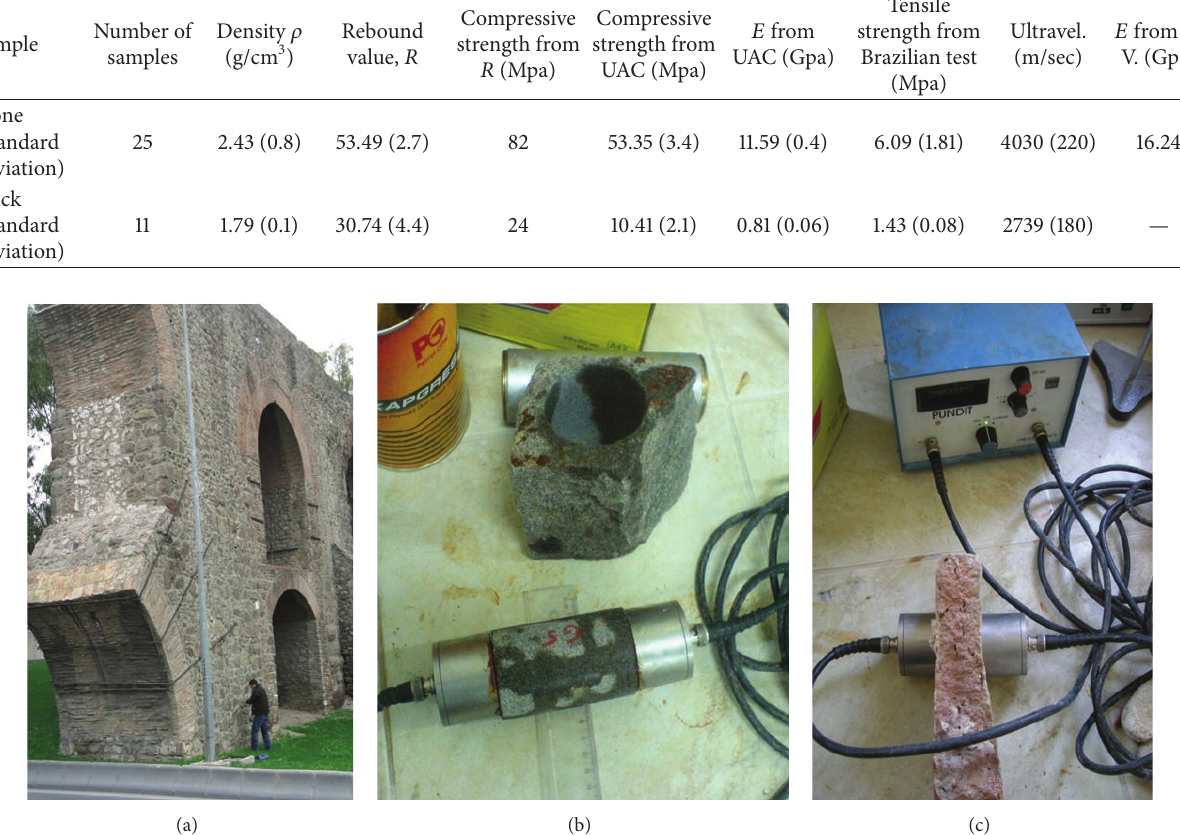
Table 1: Test results of stone and clay brick.